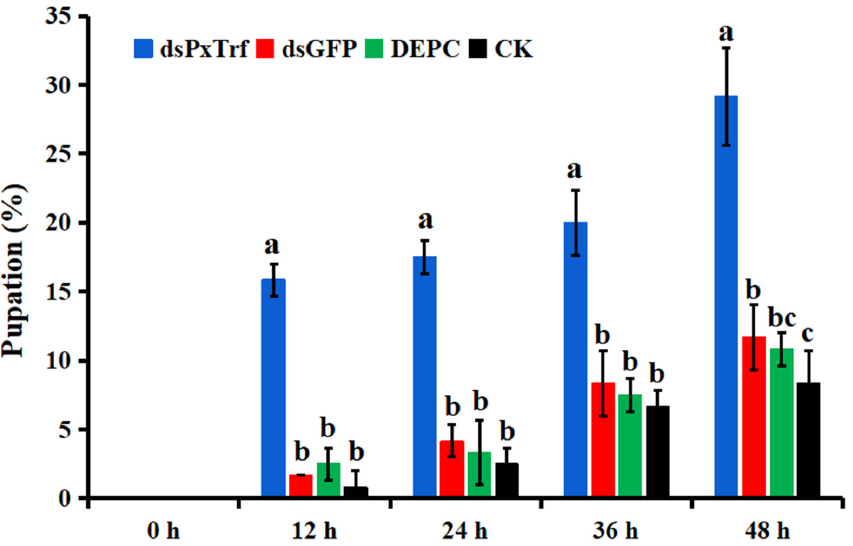
Figure 7. Pupation rate of larvae following dsPxTrf treatment. CK: without dsRNA injection. dsPxTrf: dsPxTrf injection. dsGFP: dsGFP injection. DEPC: DEPC-treated water injection. Data are presented